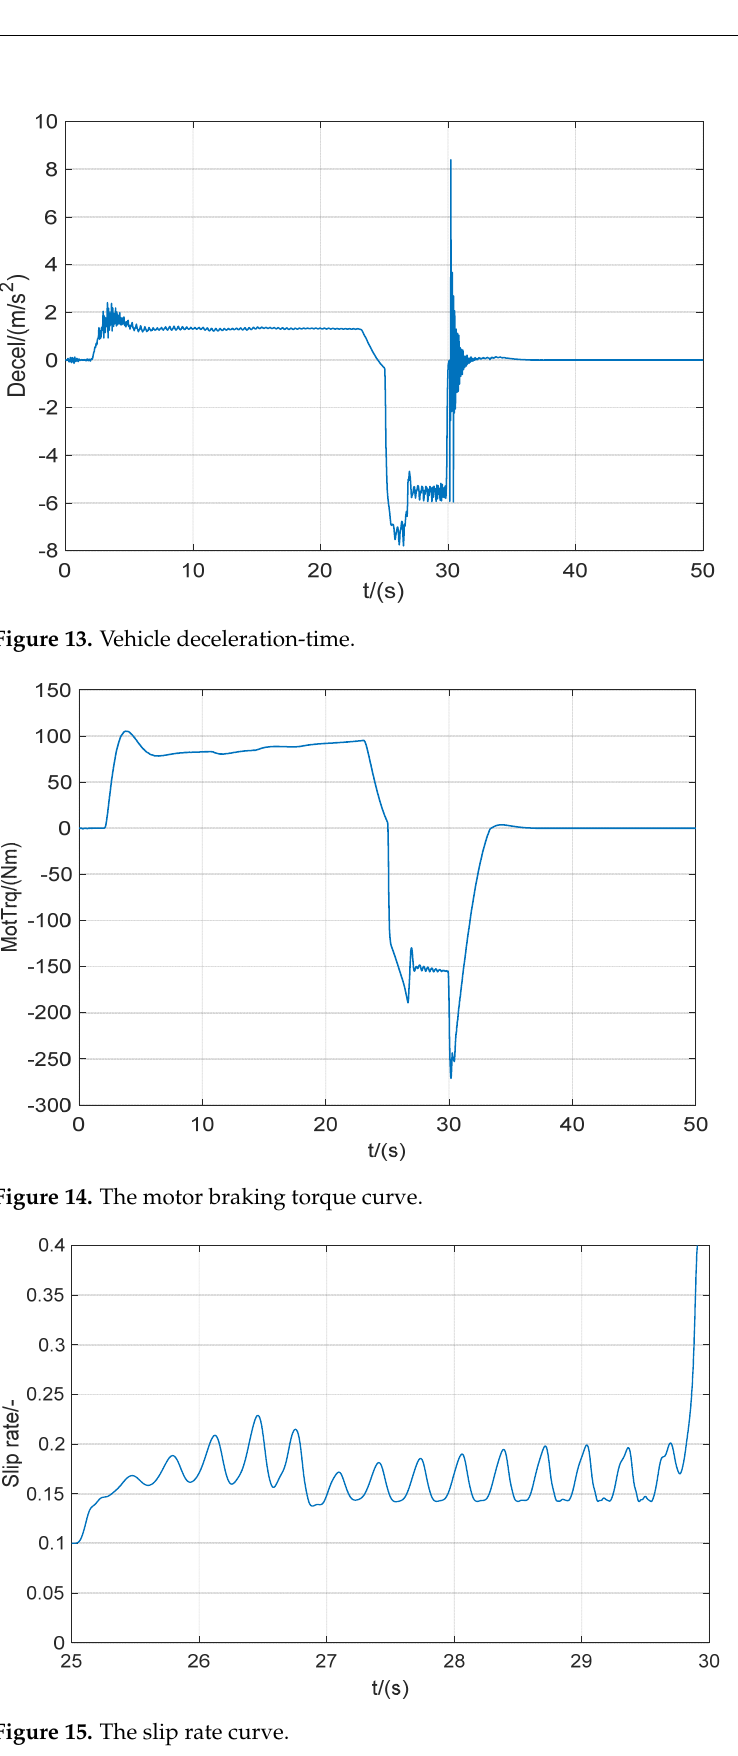
Figure 12. Target speed-time vs. actual speed-time.